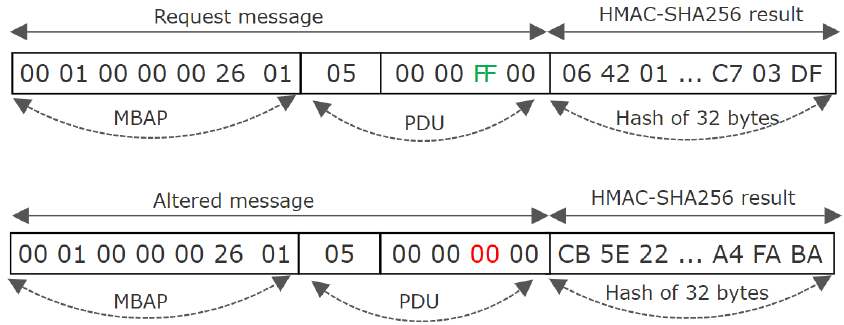
Figure 6. Modbus TCP message structure based on HMAC-SHA256 proposed concept.